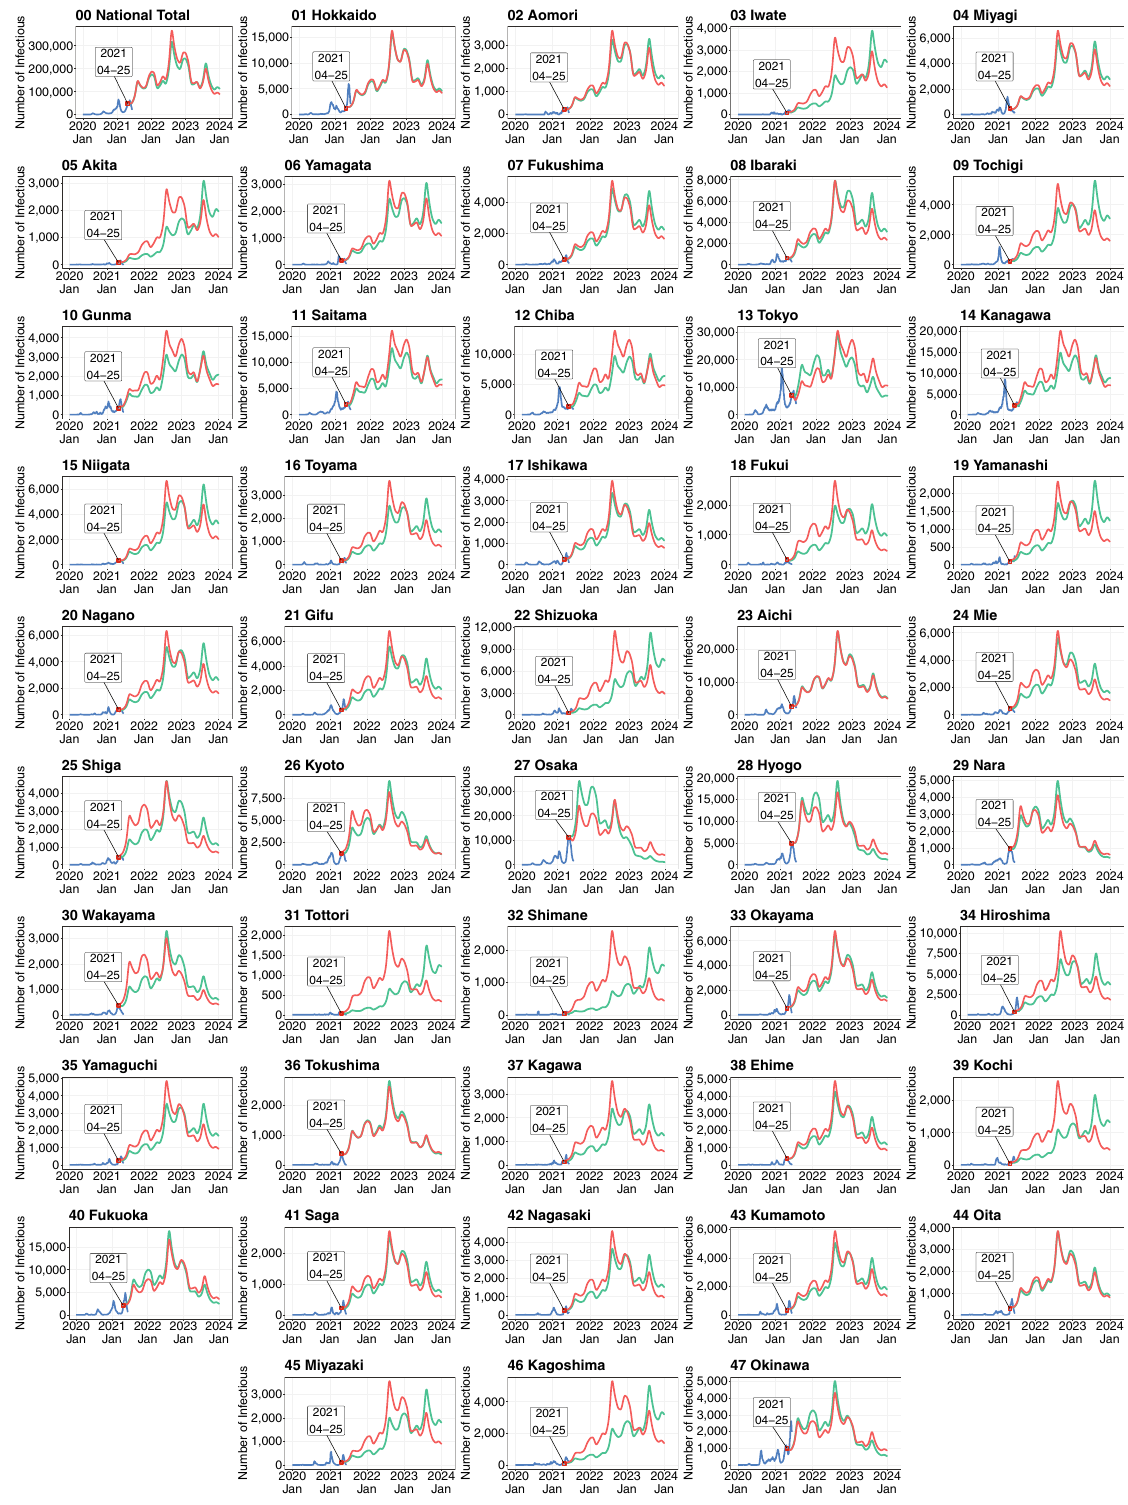
Figure 5. Simulated numbers of infectious persons by prefecture. Shown are the observed numbers of infectious people (blue lines) and the numbers of infectious people simulated by the spatial SEIR model with and without interregional mobility (red and green lines, respectively). The simulations were started on April 25,